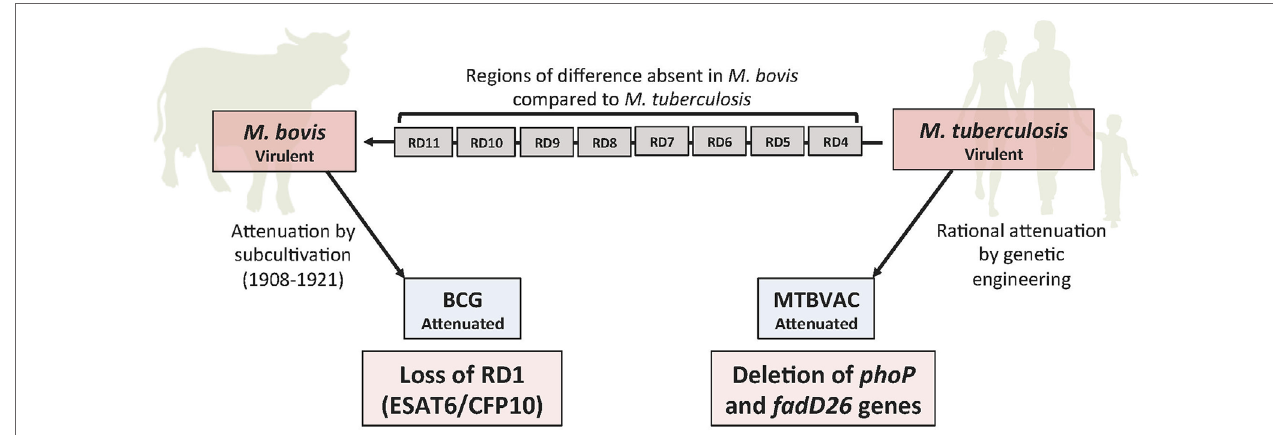
FiGURe 1 | Genomic deletions between human and cattle tuberculosis pathogens. Eight regions of difference (RD) deleted in the bovine pathogen Mycobacterium bovis with respect to the human pathogen Mycobacterium tuberculosis . Repeated subcultivation of an M. bovis strain for 13 years (1908–1921), following classical Pasteur ’ s postulates, led to attenuation due to loss of RD1, giving rise to Bacille Calmette-Guérin (BCG). MTBVAC is the result of the rational attenuation of an M. tuberculosis clinical isolate by genetic deletions of the two independent virulence genes phoP and fadD26 , following molecular Pasteur’s postulates for attenuated vaccines